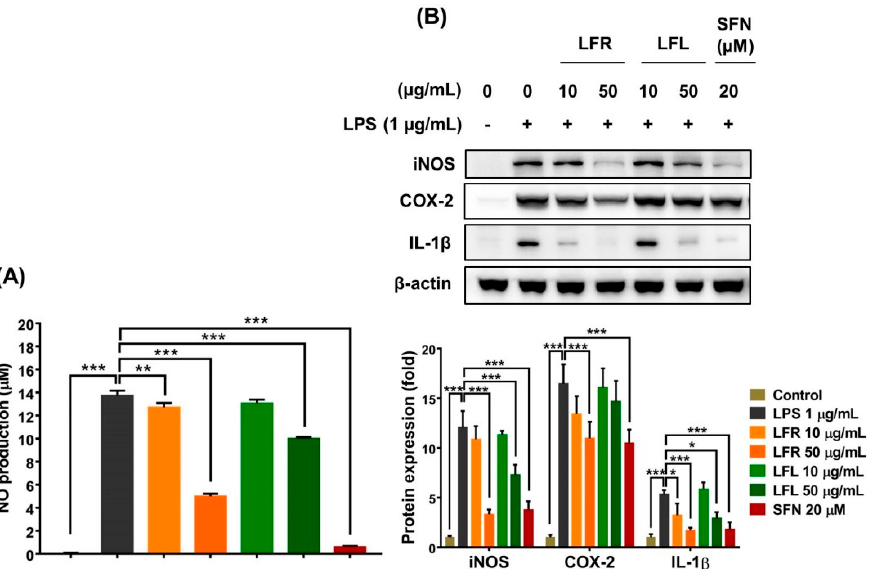
Figure 3. Anti-inflammatory activities of root and leaf extracts from L. fischeri in LPS-stimulated RAW 264.7 cells. The cells were pretreated with LFR or LFL for 1 h prior to LPS (1 µ g/mL) incubation for an additional 12 h. ( A ) NO production. ( B ) iNOS, COX-2, and IL-1 β expression. Results are presented as the mean ± S.D. of at least three independent experiments. * p < 0.05, ** p < 0.01, and *** p < 0.001 are considered statistically significant differences. LFR and LFL: L. fischeri root and leaf extracts, respectively; SFN: sulforaphane; LPS: lipopolysaccharide.